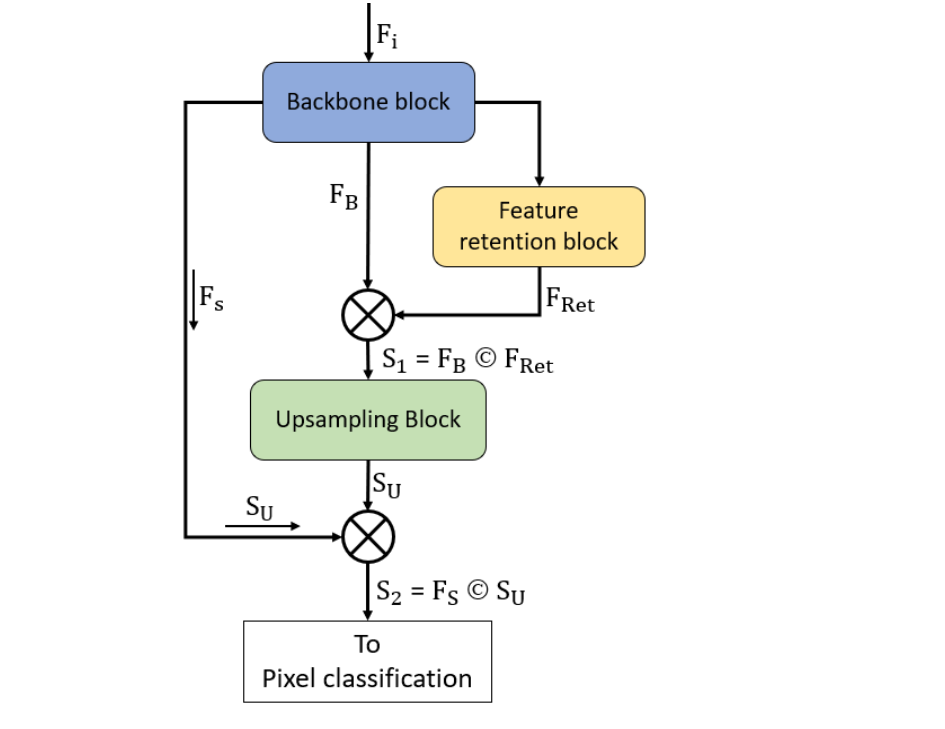
Figure 3. Understanding of VSUL-Net connectivity and dense feature aggregation principle.